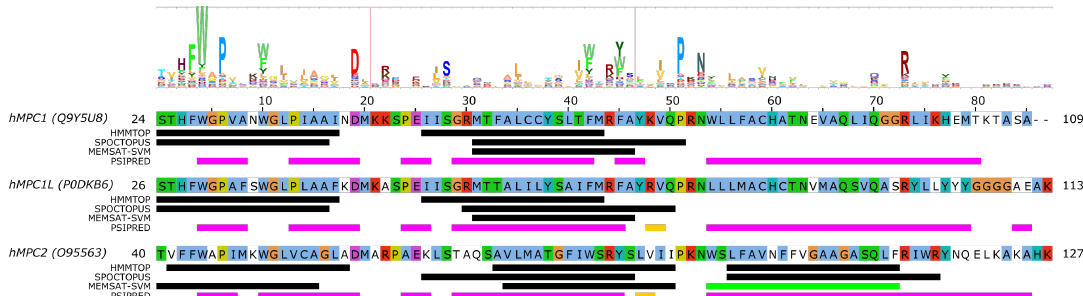
Figure 2. Sequence analysis of human MPC (SLC54) proteins. The diagram above the alignment shows the part of the HMM logo corresponding to the sequence (see text). At each position in the HMM logo, higher columns correspond to higher sequence conservation, and letters are drawn proportional to their frequency of occurrence at that position. Vertical lines in the HMM logo show positions with non-zero insertion frequency. Transmembrane regions predicted by three different methods (HMMTOP, SPOCTOPUS, MEMSAT-SVM) are marked by black lines. Green lines mark transmembrane regions predicted to by pore-lining by MEMSAT-SVM. Secondary structure as predicted by PSIPRED is shown as magenta lines ( α -helix) and golden lines ( β -strand). Uniprot sequence identifiers are shown next to protein names for each